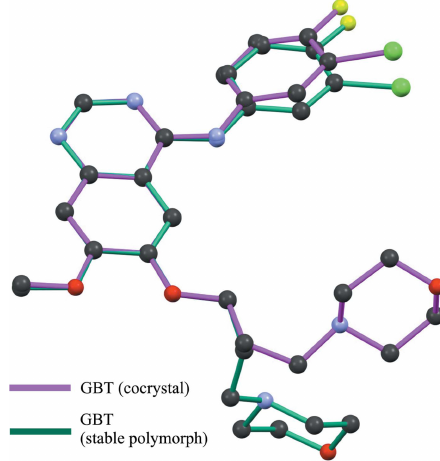
Figure 2 Crystal structures of GTB ( a ) and AA ( b ) in the co-crystal showing positional disorder of the halophenyl ring and alkyl chain, respectively.